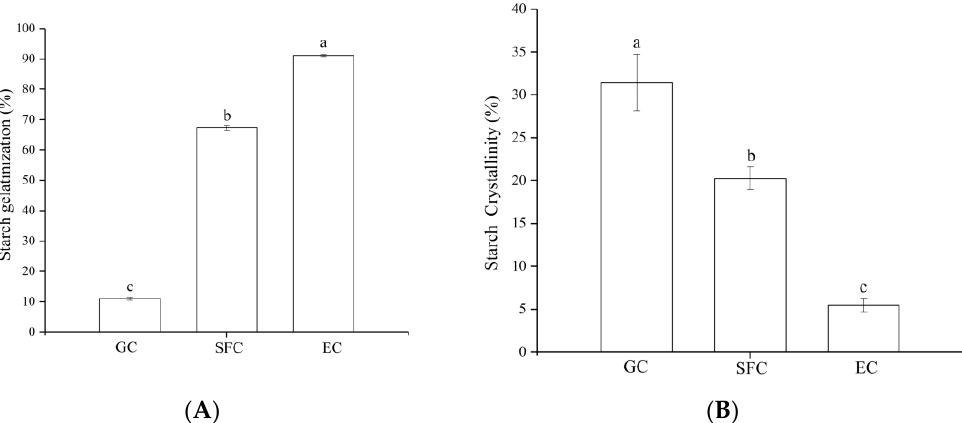
Figure 1. Starch gelatinization ( A ) and crystallinity ( B ) of corn processed in different ways. GC: ground corn; SFC: steam-flaked corn; EC: extruded corn. a, b, c : Means with different superscript letters indicate a significant difference ( p < 0.05).